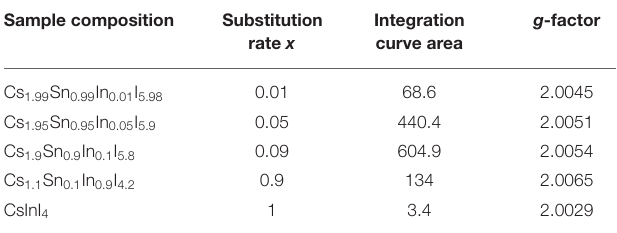
TABLE 2 | ESR spectra characteristics. Sample composition Substitution